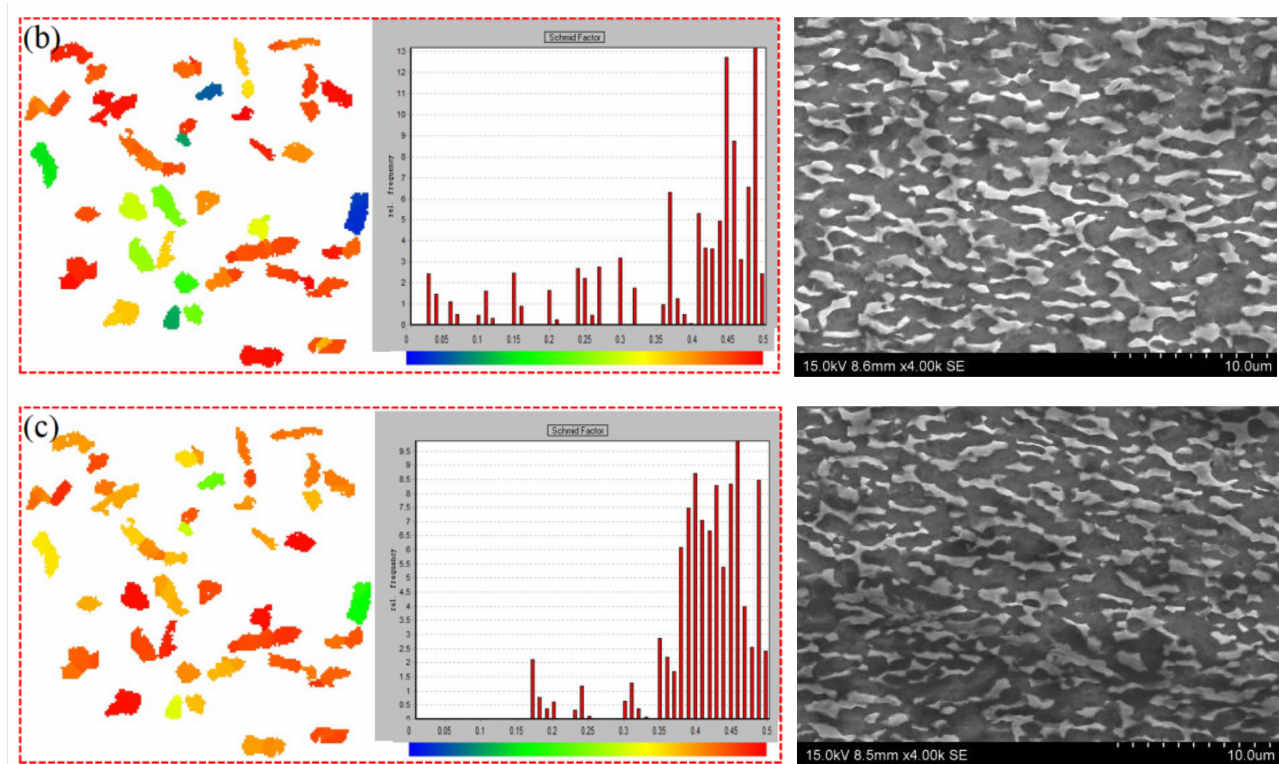
Figure 10. Schmid factor maps for SP700Cr alloy after AC820 + AC500: ( a ) {0001}<11–20>, ( b ) {1–100}<11–20> and ( c )